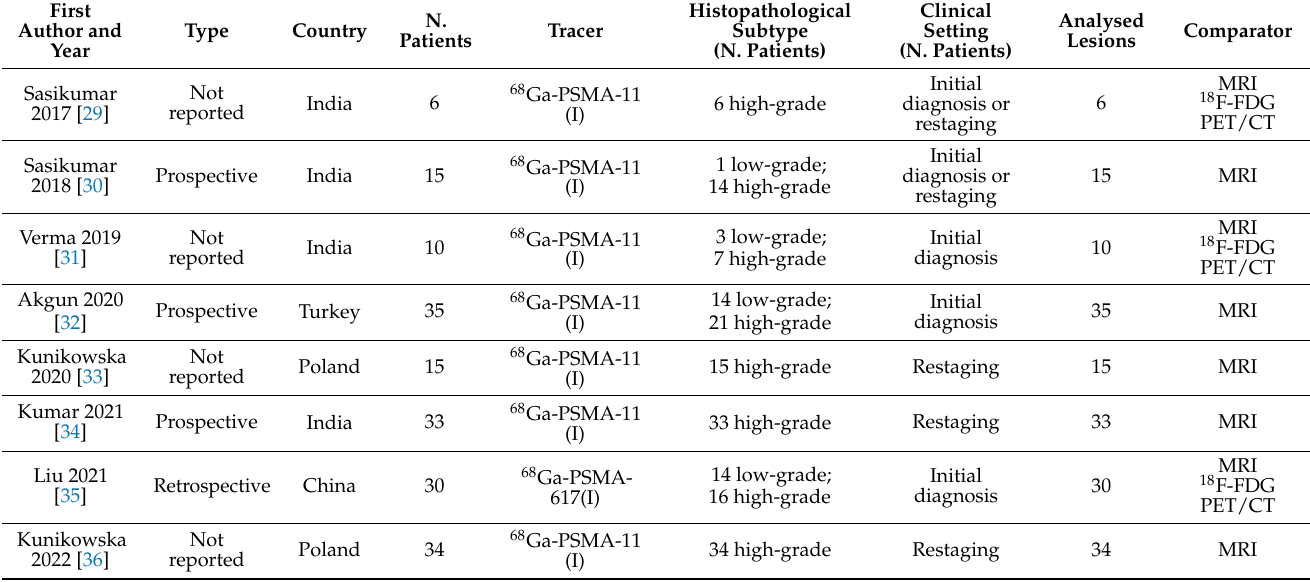
Table 1. Characteristics of the included studies which employed PSMA radioligands in